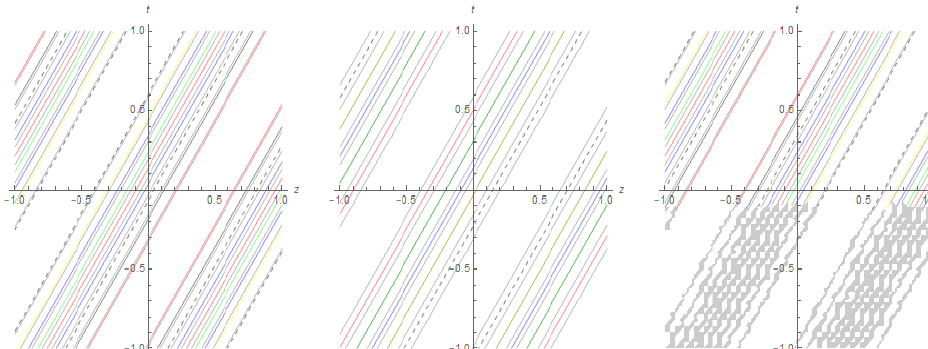
Figure 20. Contour slots for Figure 19.